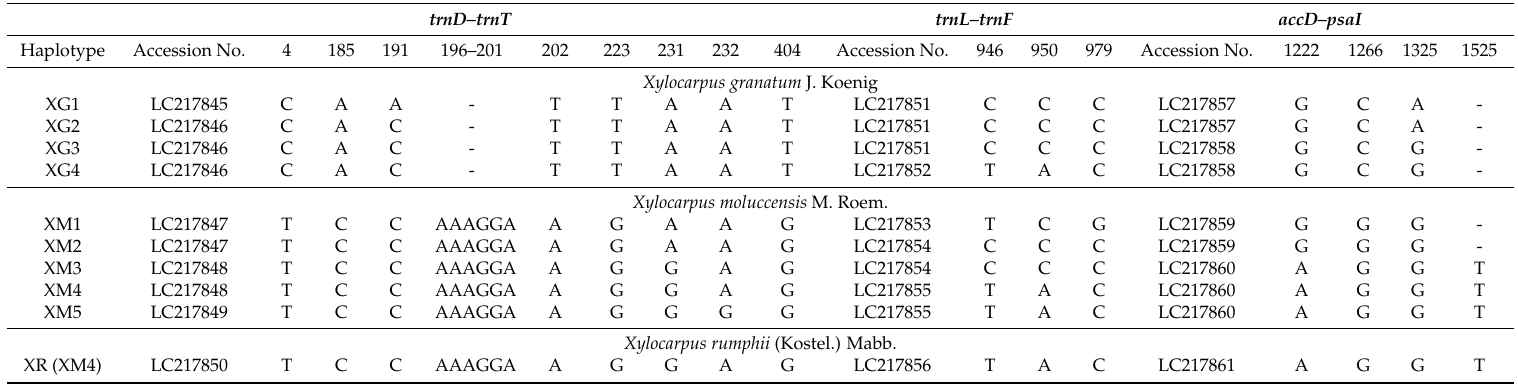
Table 2. Haplotypes identified by the concatenated sequences of three cpDNA intergenic regions. Polymorphic sites are designated by columns with the positions in the alignment of concatenated